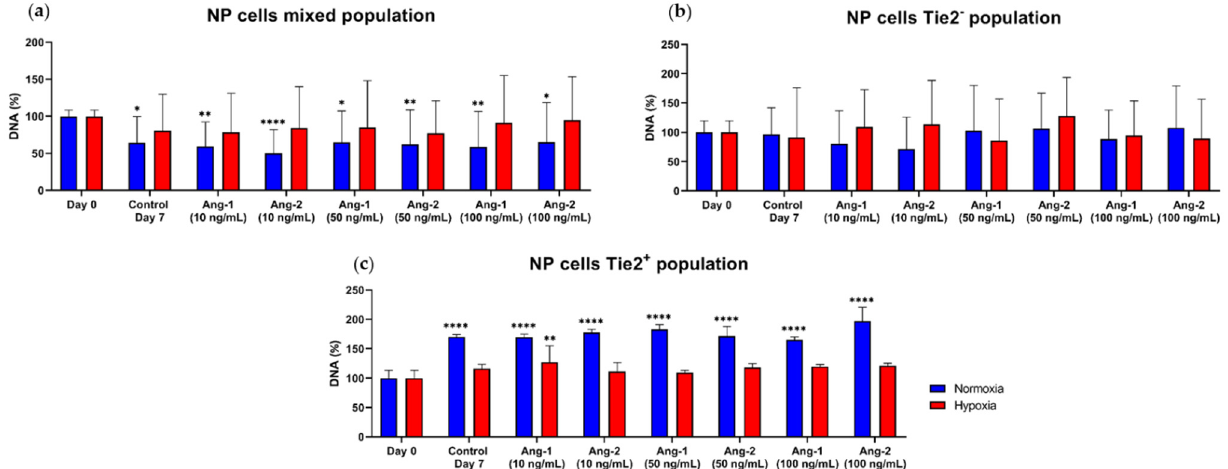
Figure 1. Amount of DNA measured of NP cells populations under normoxia and hypoxia assessed by Hoechst DNA assay on Day 7. Ang-1 and Ang-2 were administrated in three concentrations: 10, 50 and 100 ng/mL. The control Day 0 samples were used as reference. ( a ) Amount of DNA measured of NP cells mixed population (N = 7); ( b ) amount of DNA measured of NP cells Tie2 − population (N = 3); ( c ) amount of DNA measured of NP cells Tie2 + population (N = 2). Bars represent mean ± SD. A p -value < 0.05 was considered significant. Asterisks within figures denote the degree of statistical relevance observed: * < 0.05; ** < 0.01; **** < 0.0001.